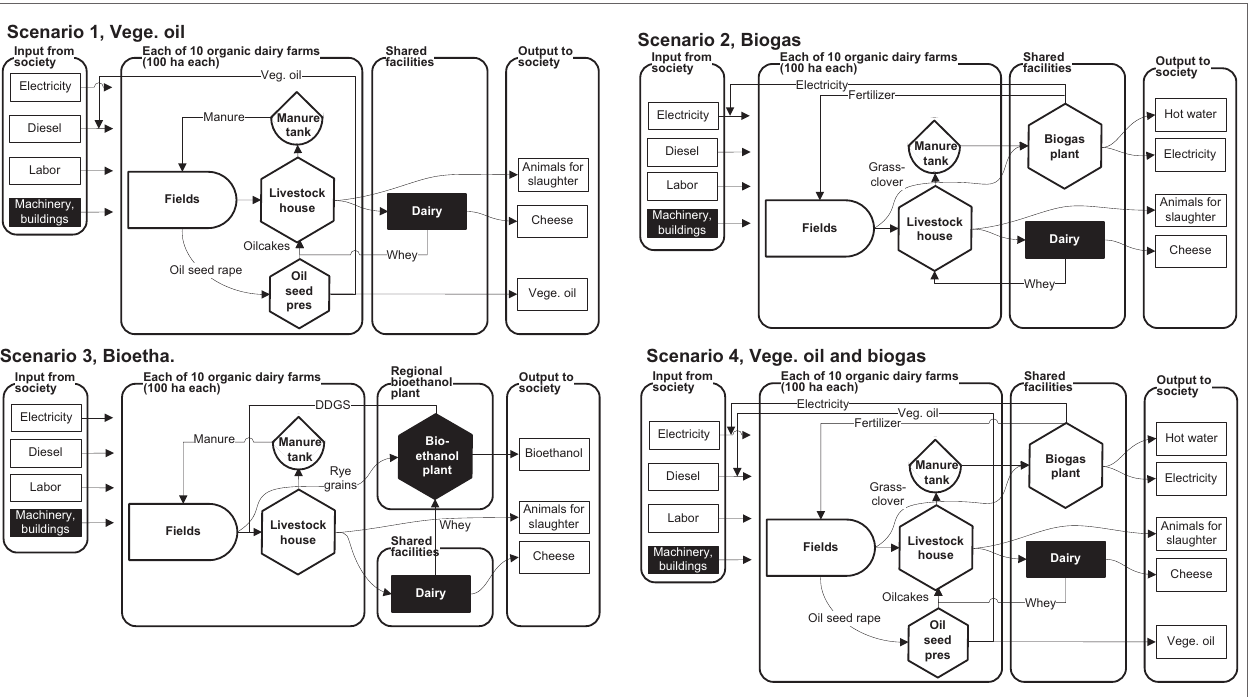
FigUre 2 | Material and energy flows in bioenergy scenarios . Scenario 1: 10% land used for oilseed rape, which is used to produce oil to substitute imported diesel and oilcake used for fodder. Scenario 2: 10% land used to produce grass-clover that is fed to the biogas facility together with manure from the cows. The biogas is used on location to produce heat and power, which is used in the system and the surplus is exported to society. Scenario 3: 10% land used to produce rye for ethanol production together with whey at a central bioethanol plant. The ethanol is exported to surrounding economy. Residues from ethanol production (DDGS) are fed back to the livestock. Scenario 4: 10% land used for oilseed rape and 10% used for grass-clover combining Scenarios 1 and 2. For further explanation, see text (see Crops).